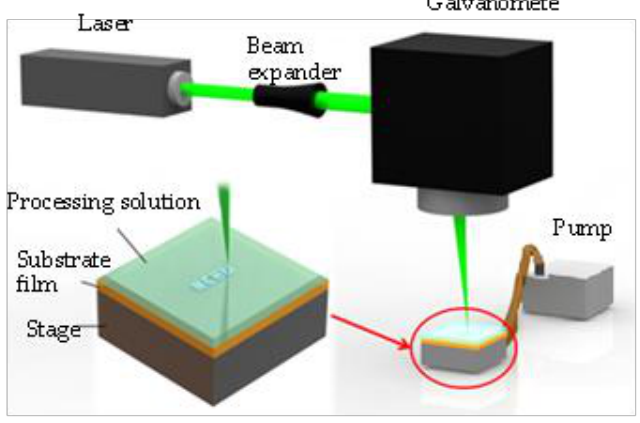
Figure 2. Experimental apparatus of laser direct synthesis and patterning